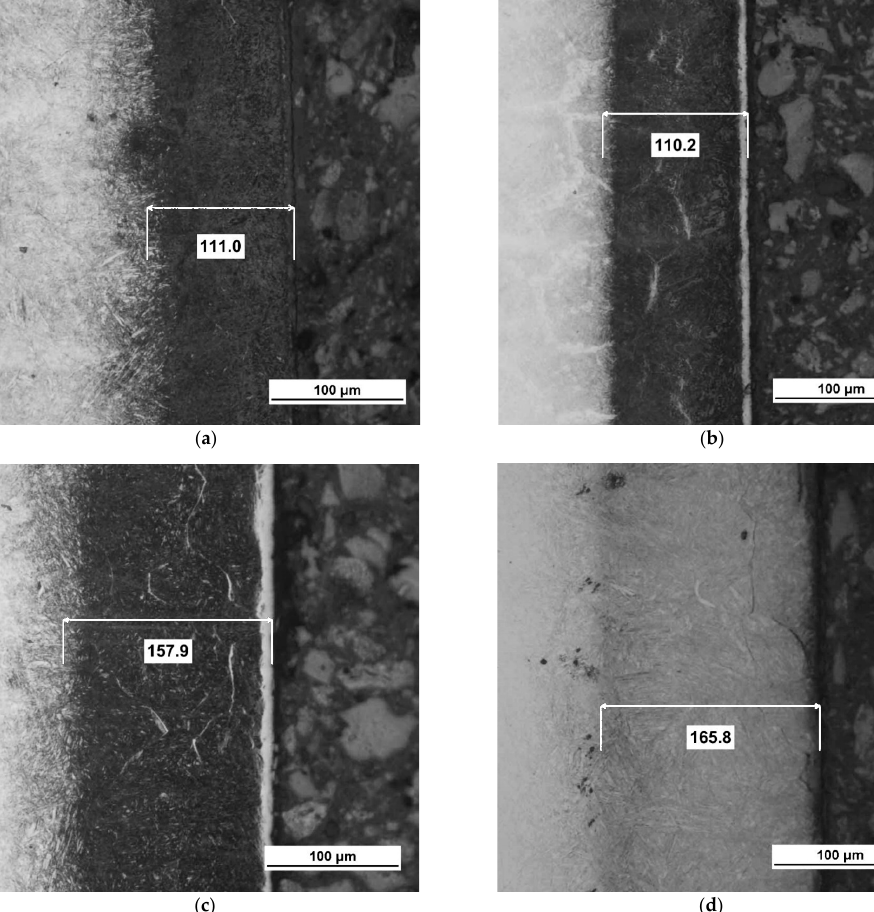
Figure 1. Microstructures of X37CrMoV5-1 steel after low-pressure nitriding processes: ( a ) process 2, ( b ) process 3, ( c ) process 4, ( d ) process 5.